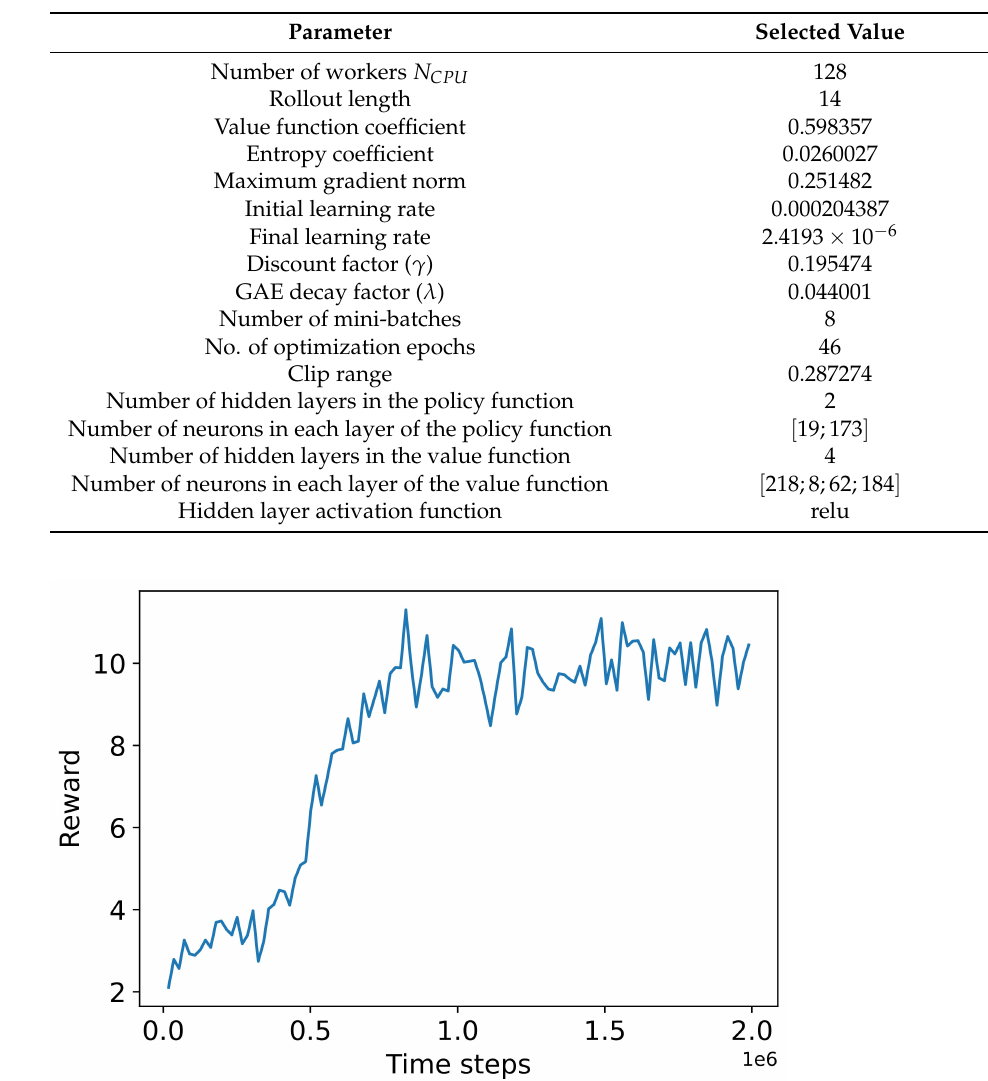
Table 1. Hyper-parameter values selected through hyper-parameter optimization.